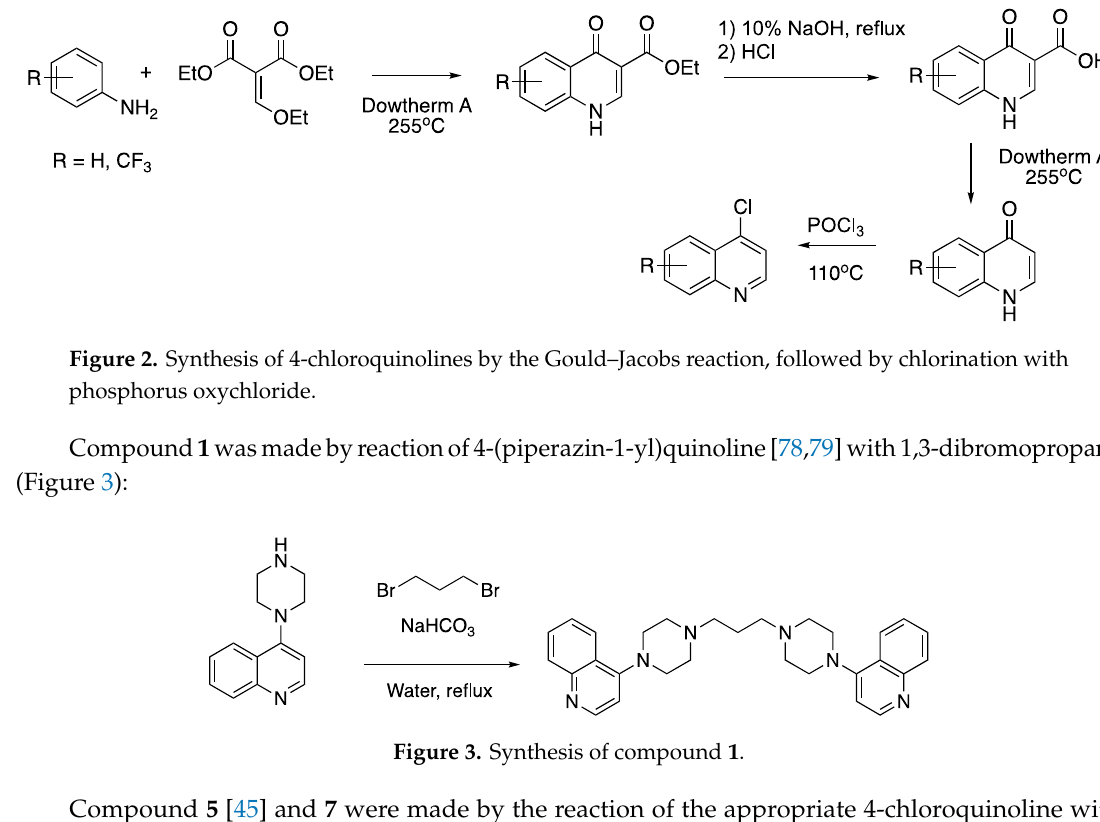
Figure 4. Synthesis of compounds 5 and 7.